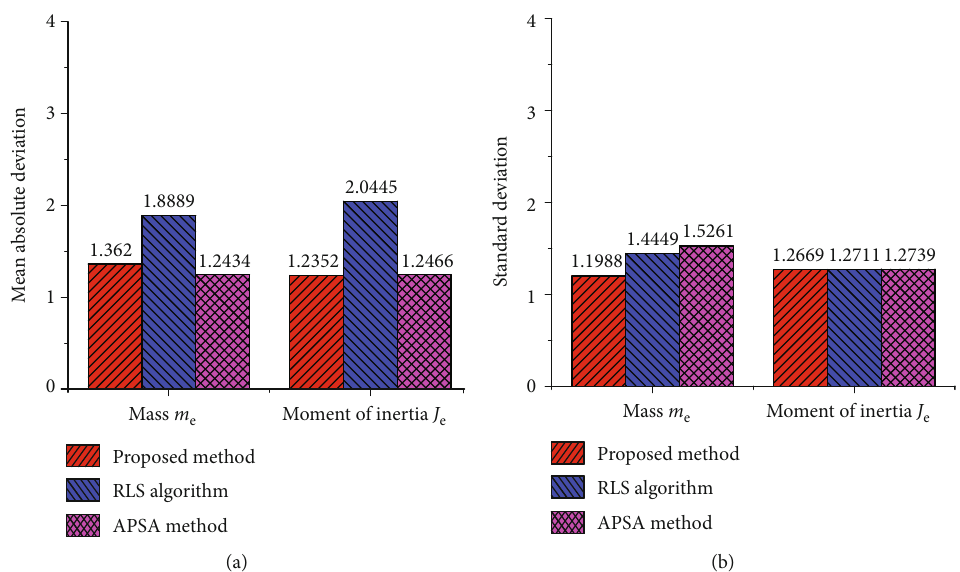
̂ J and for the three methods: (a) mean absolute deviation and (b) standard e e